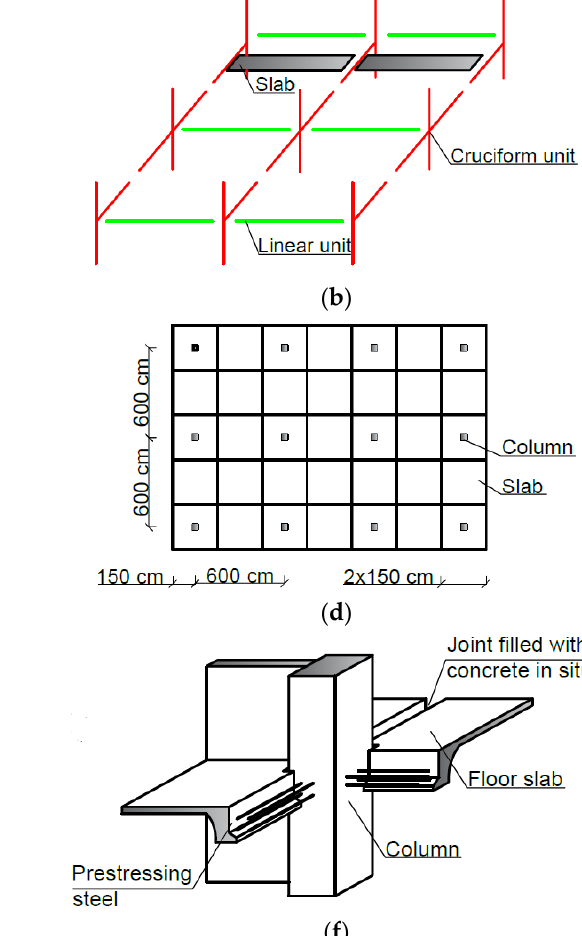
Figure 2. Elements of frame system: ( a ) a cruciform, ( b ) key load-bearing elements in a perspective. Elements of lift-slab: ( c ) key load-bearing elements ( d ) plan of a typical building. Elements of slab- column or IMS system: ( e ) axonometric view of basic components ( f ) column–slab joint (based on the information provided in